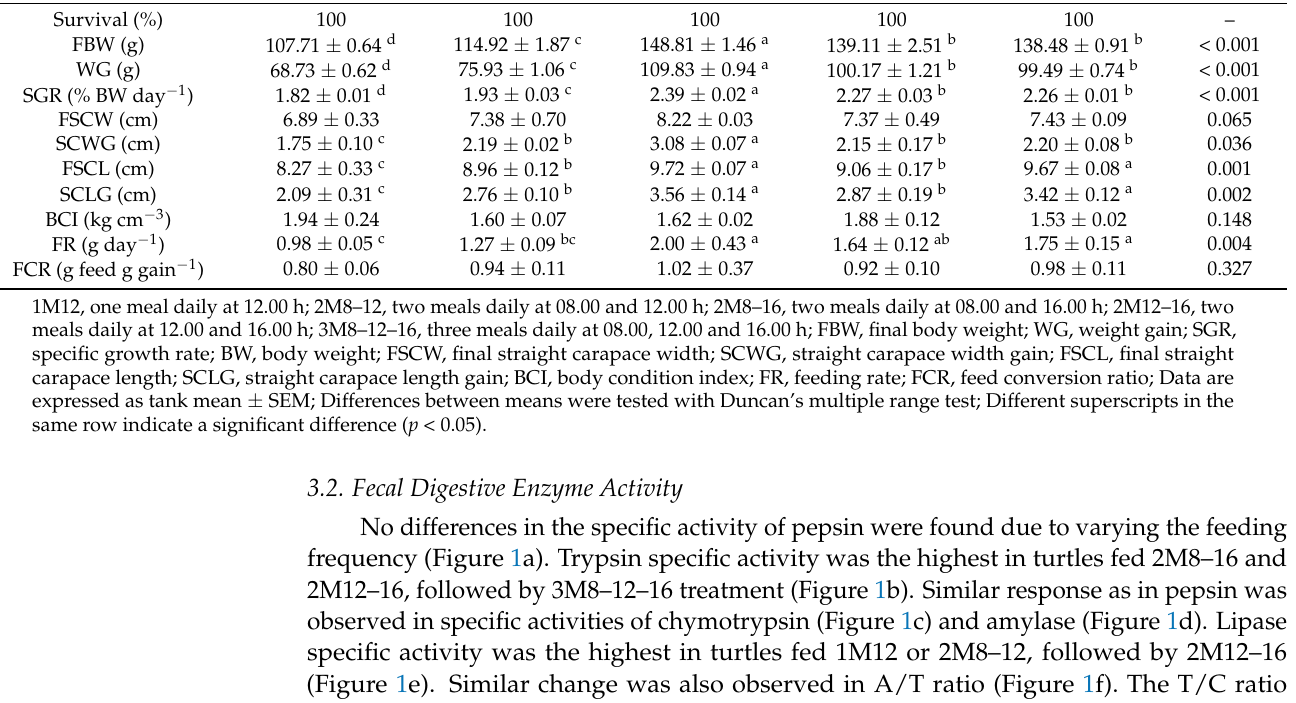
Figure 1. Specific activities of fecal digestive enzymes in hawksbill sea turtle fed at different fre- quencies: pepsin ( a ), trypsin ( b ), chymotrypsin ( c ), amylase ( d ), lipase ( e ), A/T ratio ( f ), and T/C ratio ( g ). The feces were sampled at the end of the eight-week experiment. Data are expressed as tank mean ± SEM. Different superscripts indicate a significant difference ( p < 0.05). A/T ratio is the ratio of amylase to trypsin; T/C ratio is the ratio of trypsin to chymotrypsin.